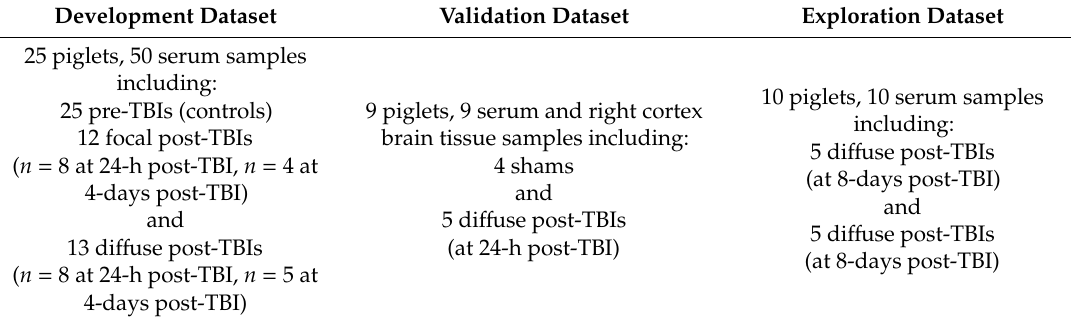
Figure 1. Schematic representation of ( a ) controlled cortical impact (CCI) device and ( b ) rapid non-impact head rotation (RNR) pneumatic device. Table 1. Details of the samples from the three datasets used in this